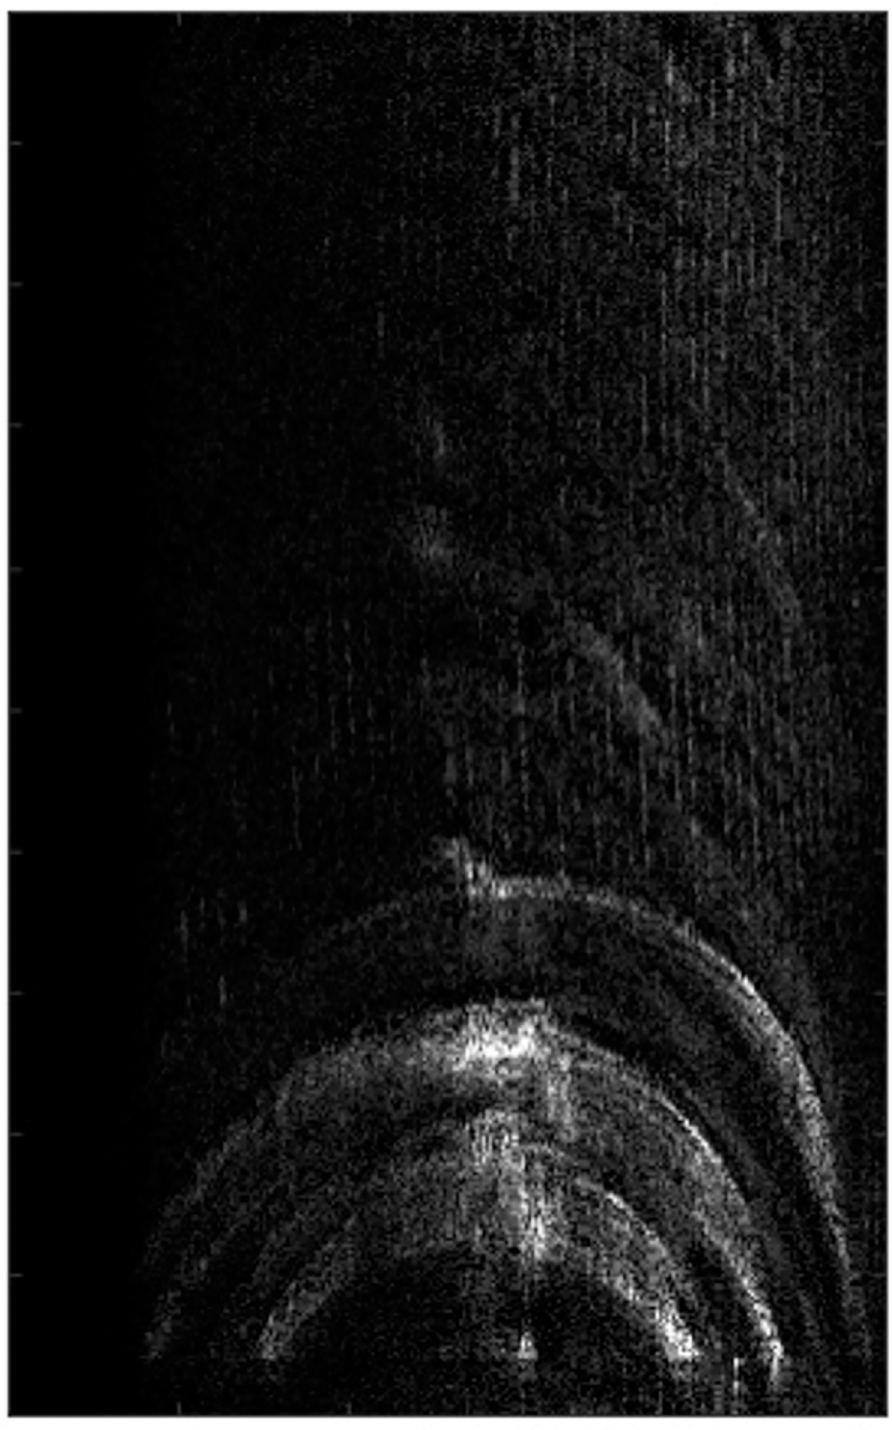
Fig 10. The real focused